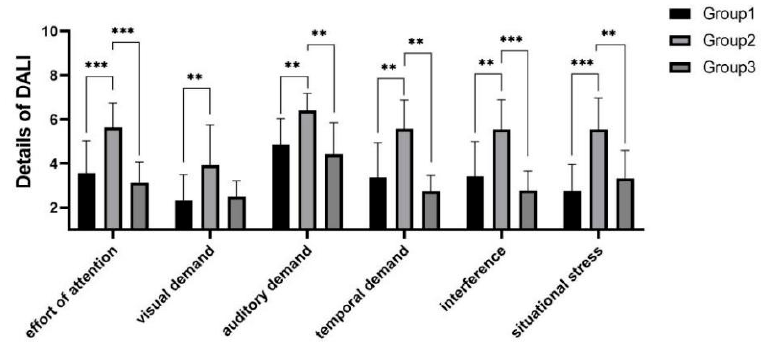
Figure 14. Workload in speeding task. ** indicates significant difference ( p < 0.01). *** indicates significant difference ( p < 0.001).